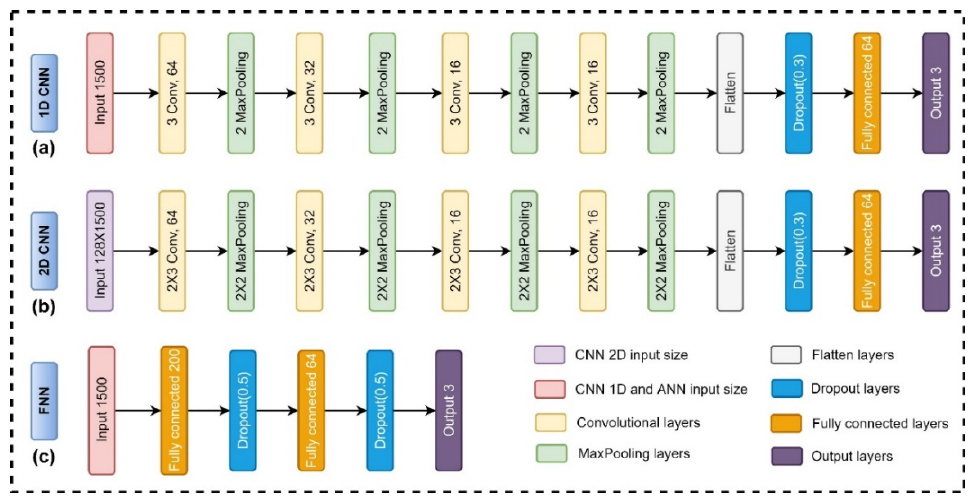
Figure 3. The architectures of three neural network models: ( a ) the 1D CNN model; ( b ) the 2D CNN model; and ( c ) the FNN model.